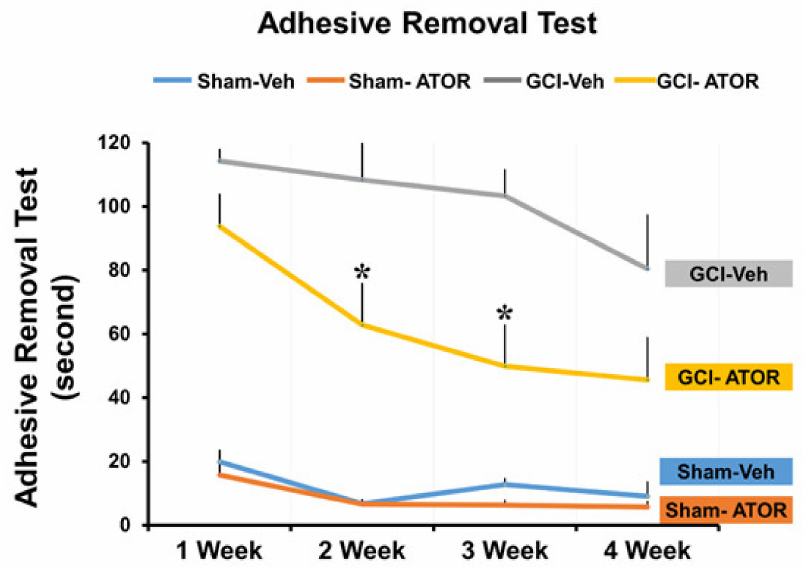
Figure 6. Atorvastatin improves the cognitive function after global cerebral ischemia. The groups treated with atorvastatin for 4 weeks were evaluated for changes in cognitive and sensory function through a series of adhesive removal tests, and the results are graphically presented. Compared with the GCI-Veh group, the GCI-ATOR group showed significantly improved cognitive impairment. Data are mean ± S.E.M., n = 5 for each sham group, n = 8–10 for each ischemia group. * Significantly different from the vehicle-treated group, * p <